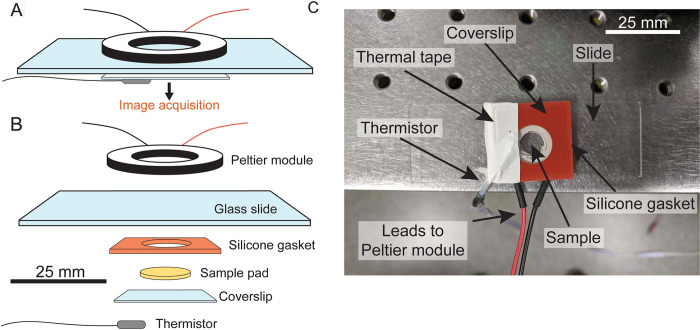
SiCTeC: An easy-to-assemble temperature controller for single-cell imaging.(A) Schematic of a temperature-controlled sample slide. A ring-shaped Peltier module delivers heat to the sample, and the temperature is monitored at the coverslip using a thermistor. Images of cells can be acquired using most microscopy systems and processed using automated segmentation and tracking algorithms. (B) Exploded schematic of the slide in (A). (C) Photo of sample slide with Peltier module and thermistor. The thermistor is sealed to the coverslip with thermal tape, and power is delivered to the Peltier module using electronic control components. SiCTeC, Single-Cell Temperature Controller.